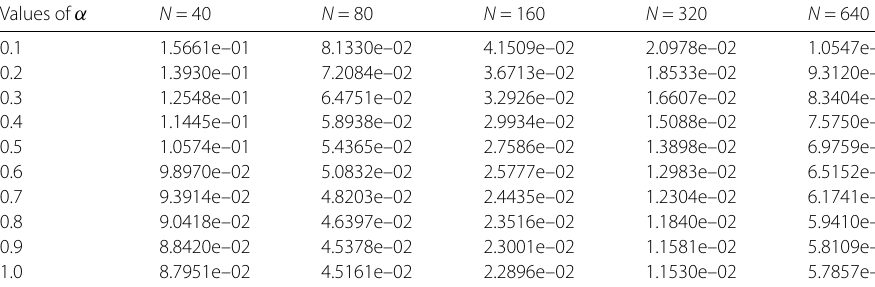
Table 3 Maximum absolute errors for Example 5.2 with r = 0.065 and δ = 0.045 Values of α N = 40 N = 80 N = 160 N = 320 N = 640 0.1